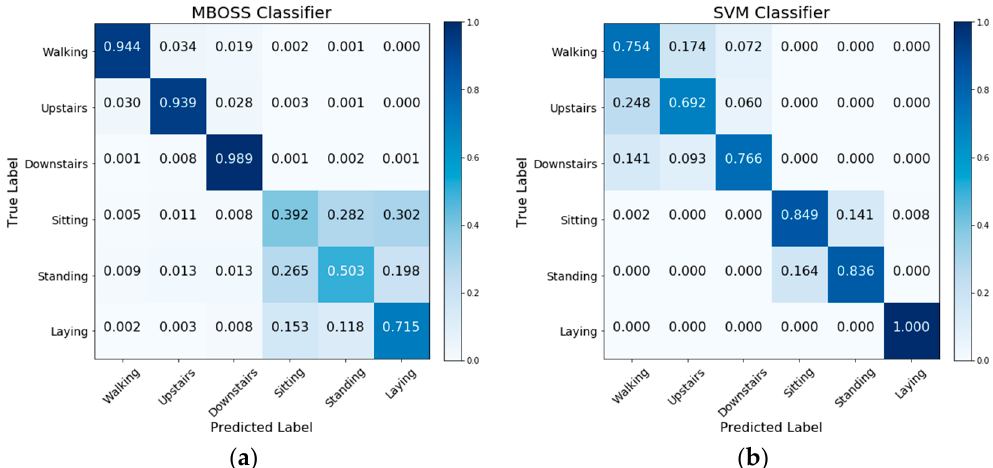
Figure 9. Confusion matrices for ( a ) MBOSS and ( b ) SVM classifiers for the UCI HAR dataset.